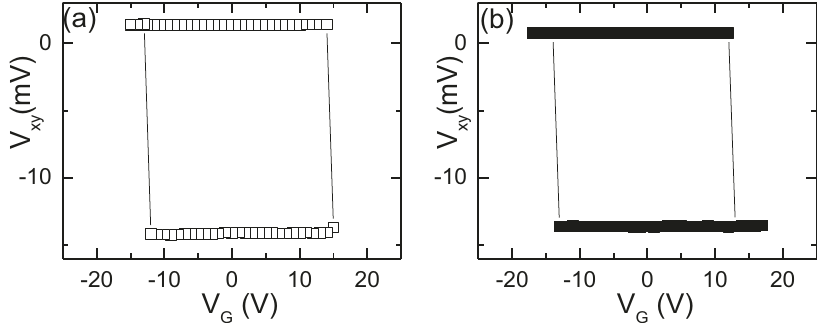
Fig. 3 Electric hysteresis of Hall-like signal. V xy versus V G hysteresis loops measured at T = 300 K in a μ 0 H = − 1 T (open squares) and b H = 0 (solid